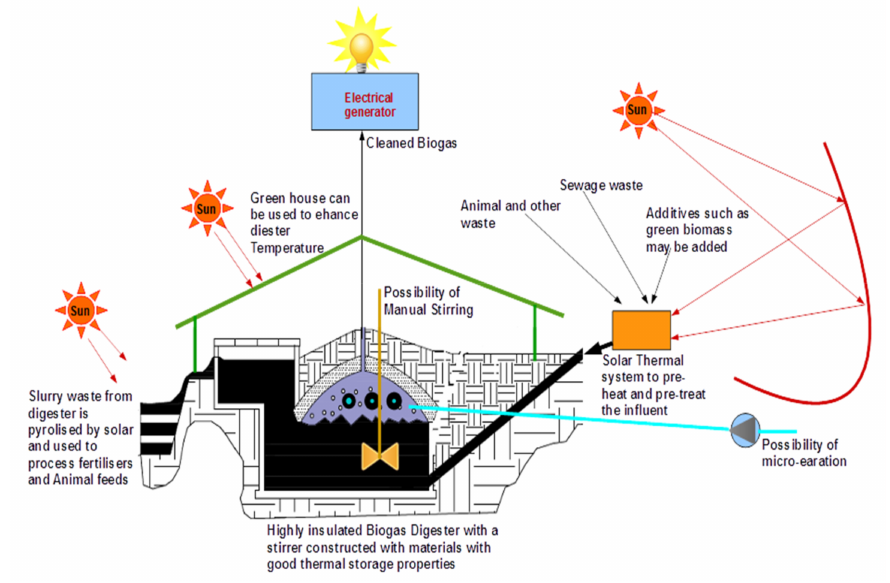
Figure 8. Model biogas-electricity generation system integrated with a solar thermal